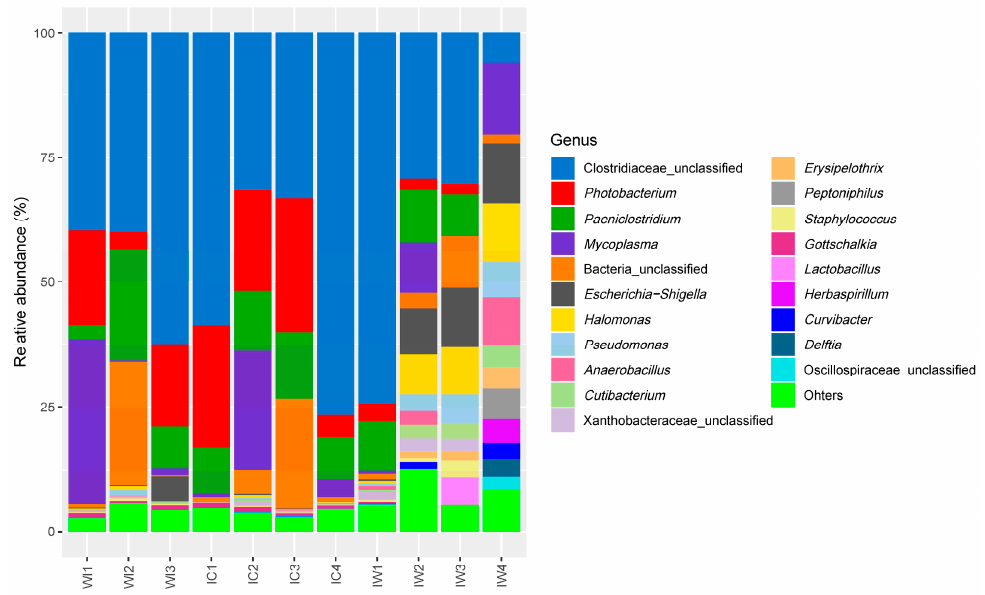
Figure 3. Genus composition of the C. gunnari gut microbiome. WI, whole intestine; IW, intestinal wall; IC, intestinal content.